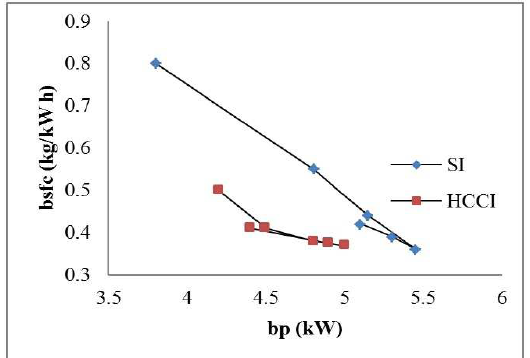
Fig. 4. bp of the two systems at HUCR for each one for wide range of equivalence ratio.